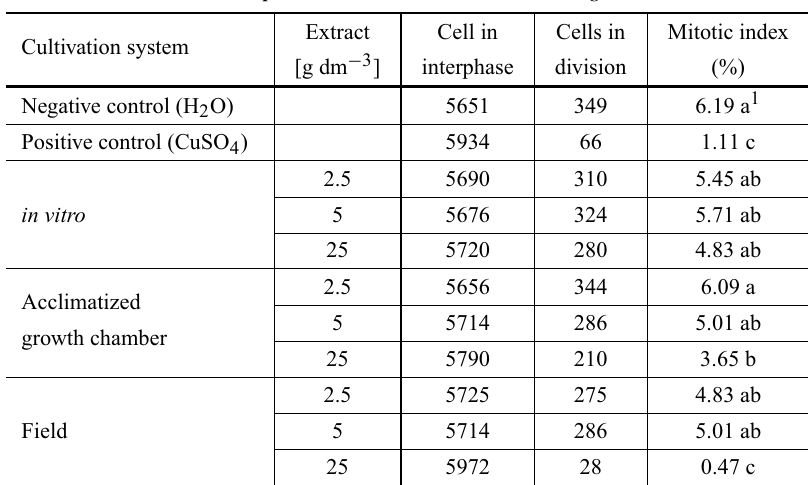
Number of cells in interphase and mitosis, as well as the mitotic index of roots of Allium cepa treated with infusions of Pluchea sagittalis . Extract Cell in Cells Cultivation system